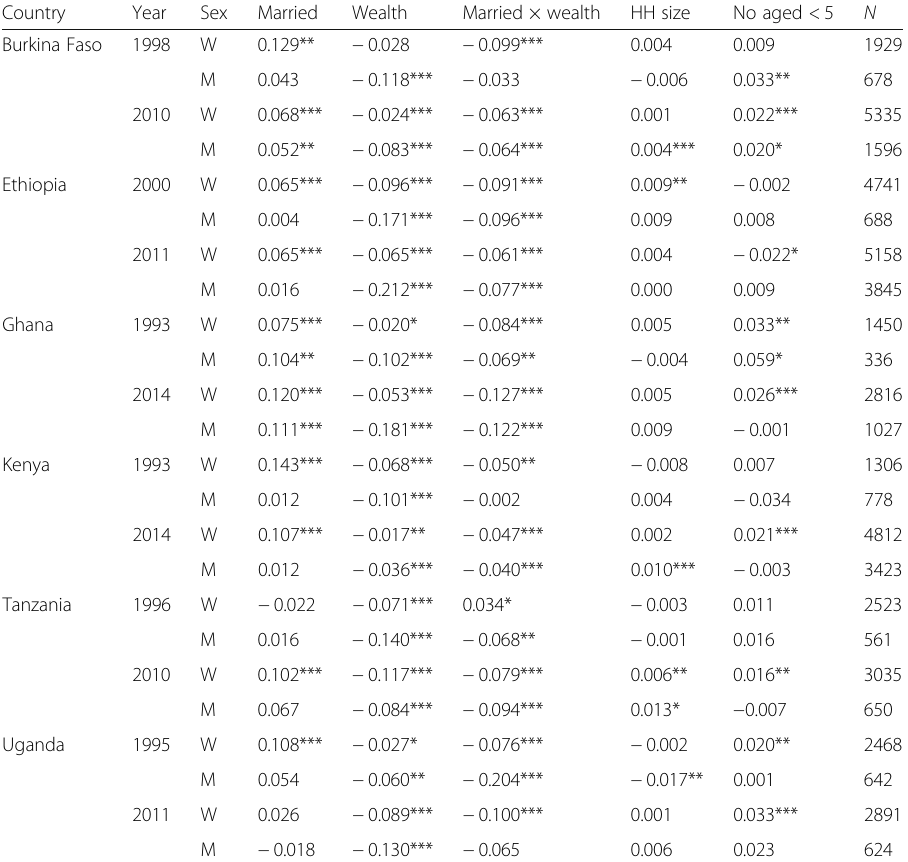
Table 9 Selected LPM regression coefficients: dependent variable: works in agriculture Country Year Sex Married Wealth Married × wealth HH size No aged < 5 N Burkina Faso 1998